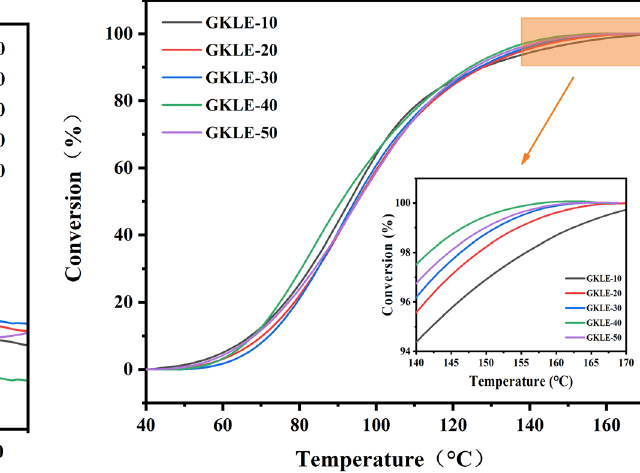
Figure 2: DSC curves of adhesives with di ff erent ECH contents.